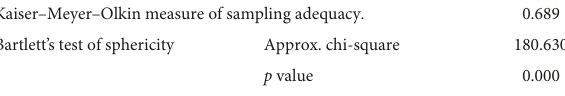
TABLE 5 Results of the test statistics for EFA analysis in the practices section of the validation study. Kaiser–Meyer–Olkin measure of sampling